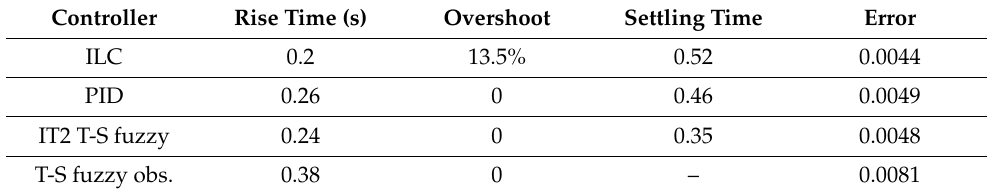
Figure 14. The comparison of controllers’ performance with respect to the tracking error. Next, we compare the performance of the controllers in overcoming the payload un- certainty, as is shown in Figure 15. The top plot in this figure shows the payload variation applied to the piston while the reference signal remains constant at 0.1 m. As is seen, the ILC-controlled system can maintain the required precession (±0.002 m) regardless of changes in the load. However, this cannot be adequately achieved with the other control- lers. The plot of the disturbance rejection error is given in Figure 16. The summation of the square of the error for the controllers is given in Table 3. Again, the ILC shows a better performance than the other controllers in overcoming the uncertainties. Table 3. Comparison between the controllers’ performance in disturbance rejection. Controller